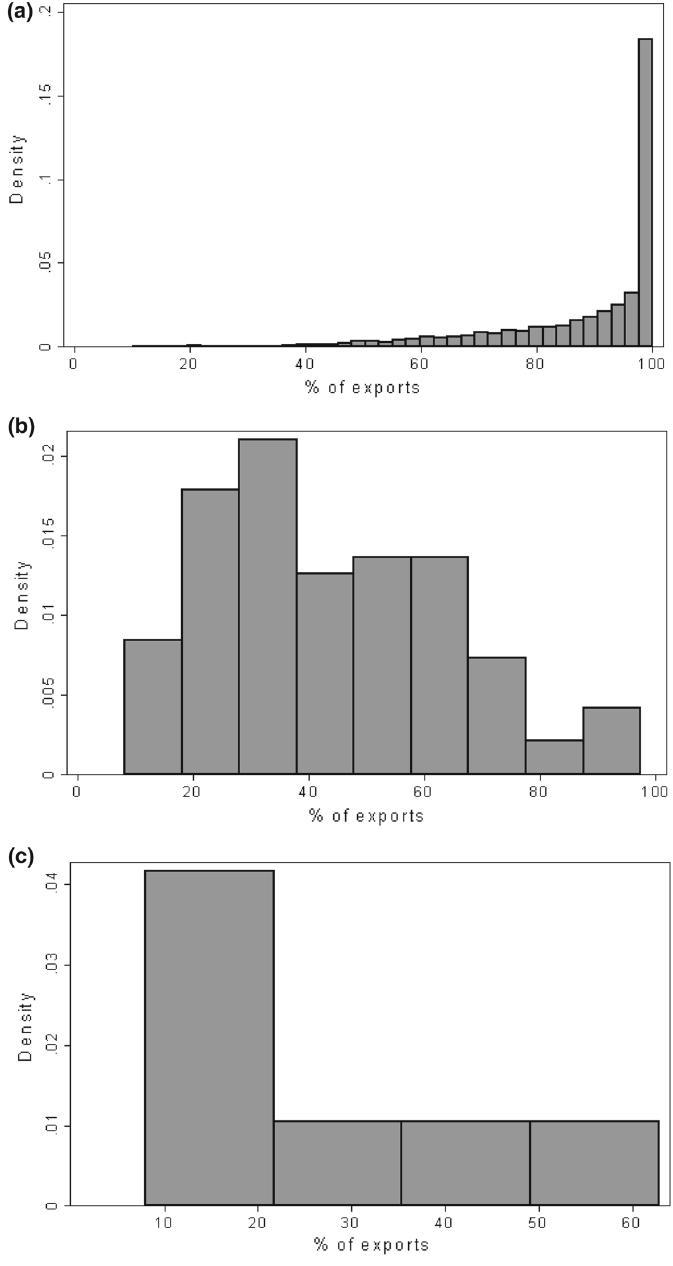
Fig. 5 Concentration of exports in the top 5 firms across products, 1997 a CN 8-digit classification (7145 products) b Export chapters (96 chapters) c Export sections (21 sections). Source: Own calculations, based on the Customs